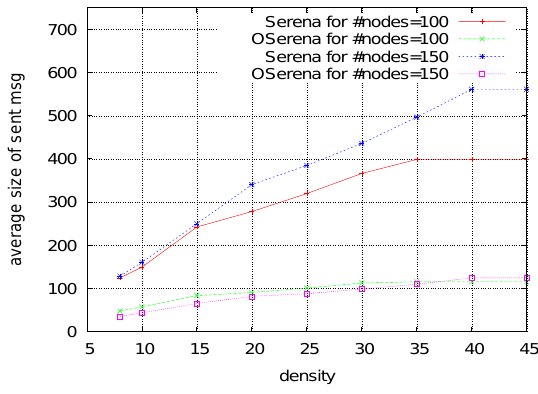
Fig. 9. Average number of bytes sent per node with SER- ENA and